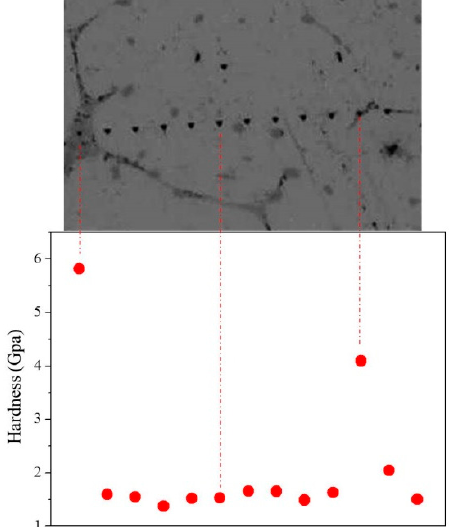
Figure 6. Hardness distribution in TS ‐ SIMA alloys evaluated using nano ‐ indentation.